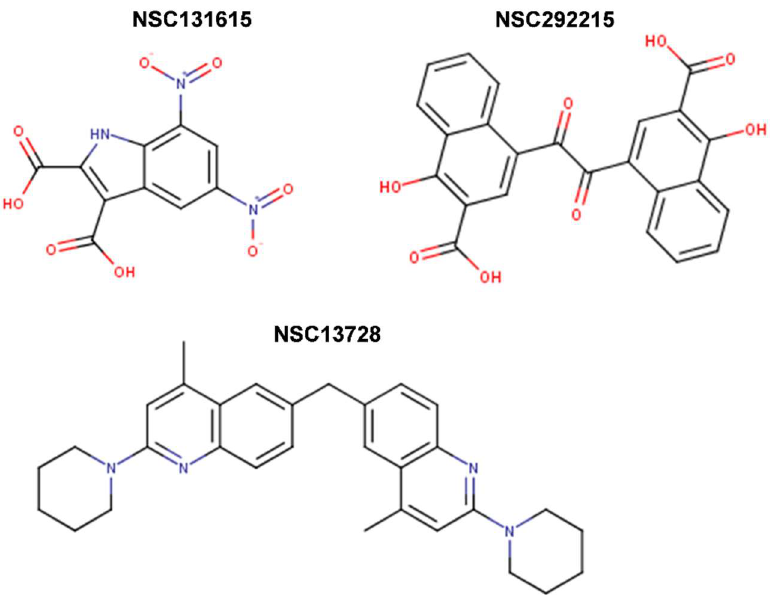
Figure 12. Chemical structures of representative Max-Max stabilizers that alter Myc-Max function by blocking binding to equivalent DNA binding sites. See text for details.